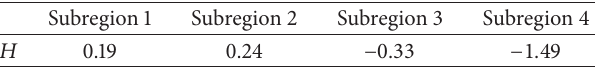
Table 4: The homogeneity measures of the four subregions in the